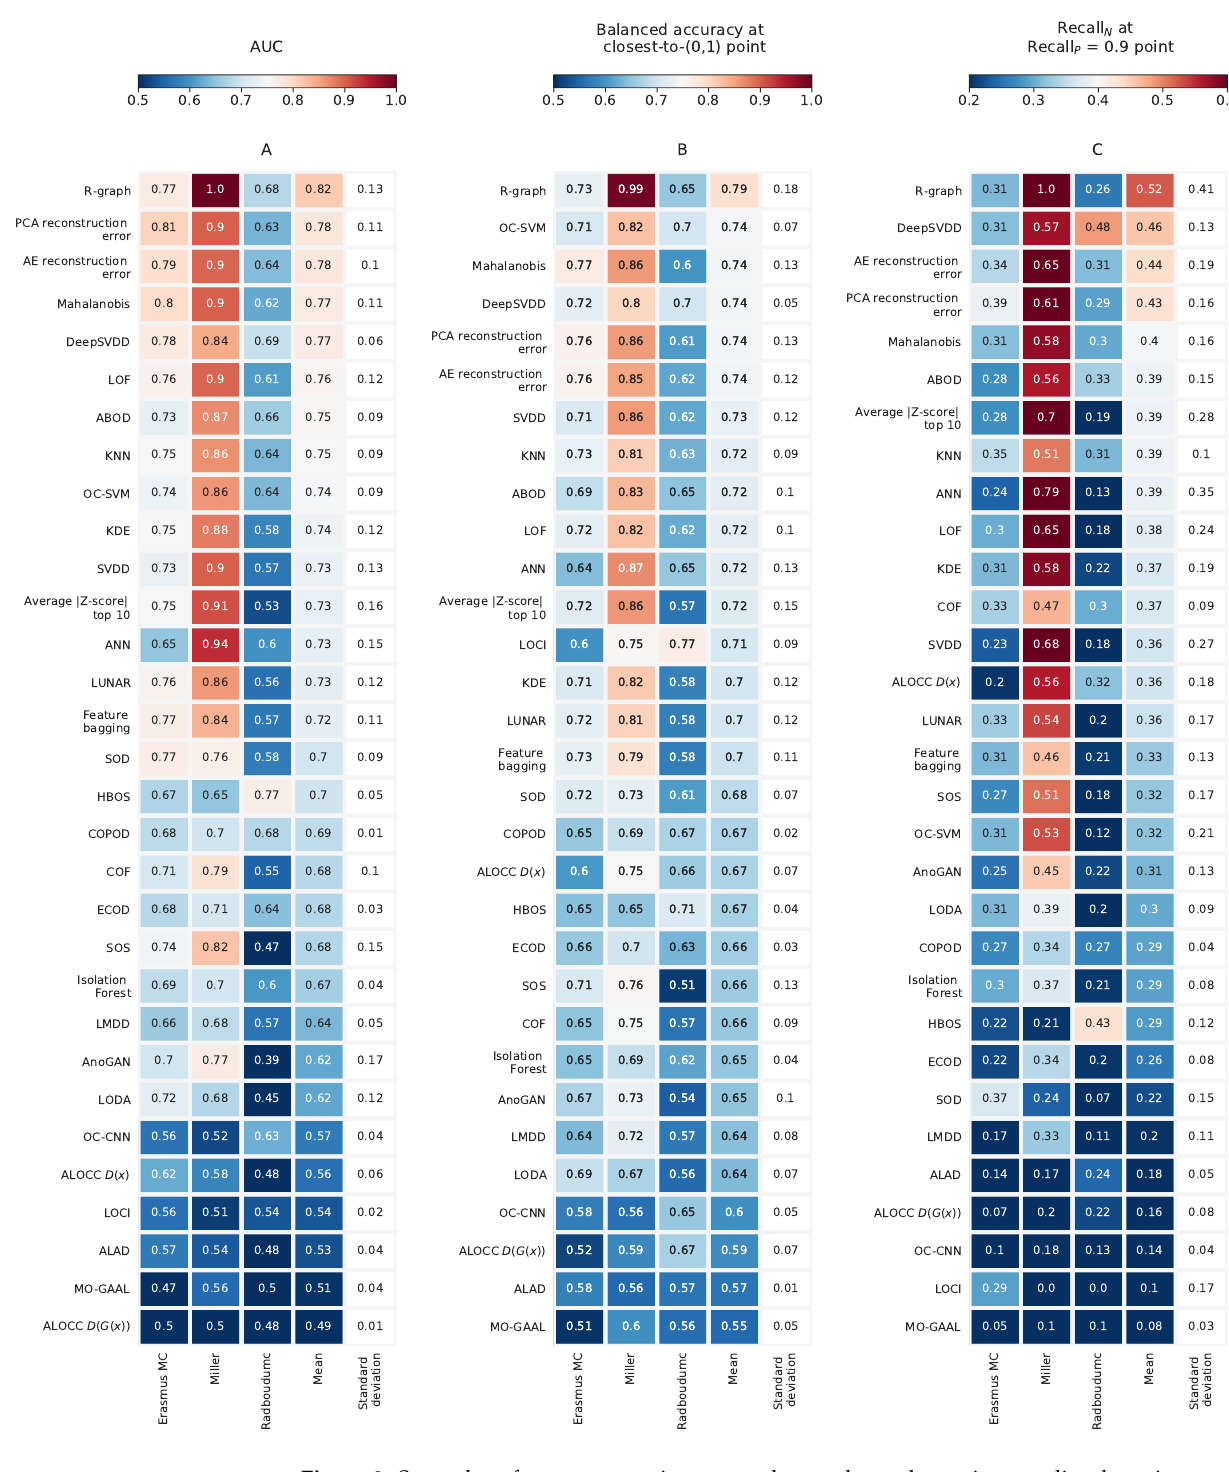
Figure 2. Several performance metrics are used to evaluate the various outlier detection methods. ( A ) Average (across the cross-validations) AUC of the ROC curves for each dataset and outlier detection method. In addition, the average and standard deviation of the AUC across all three datasets are reported. The methods are sorted based on this average AUC. ( B ) Average balanced accuracy (see Methods) at the ’closest-to-(0,1)’ point of the ROC curve for each dataset and outlier detection method. Again, the methods are sorted based on the average balanced accuracy across the three datasets. ( C ) Recall N at the ‘Recall P = 0.9’ point at the ROC